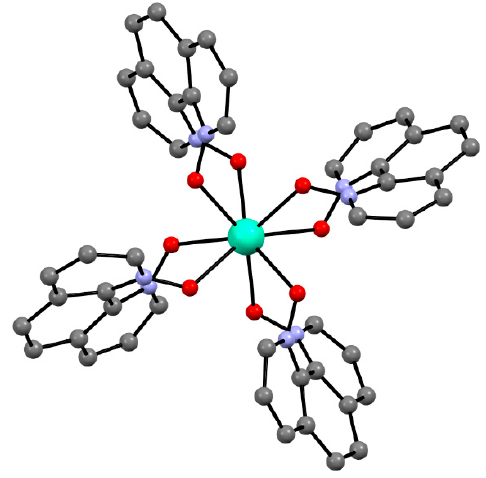
Figure 6. The crystal structure of the [Gd(phendo) 4 ] 3+ cation in compound 10 as the representative example of the isostructural series [Ln(phendo) 4 ](NO 3 ) 3 ∙ xMeOH (Ln = Er for 11 , Yb for 12 ). Gd—teal, O—red, C—gray, N—blue.